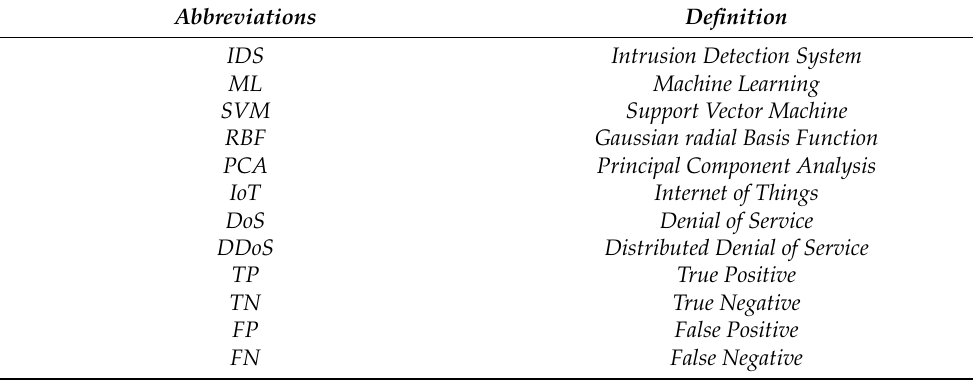
Table 1. List of abbreviations.